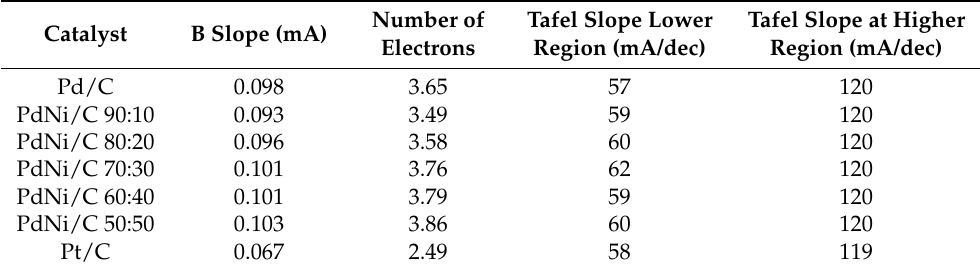
Table 4. Data derived from the Levich slopes (B), number of electrons per O 2 molecule, and Tafel slopes of the ORR for the different catalysts in 0.1 M NaOH.